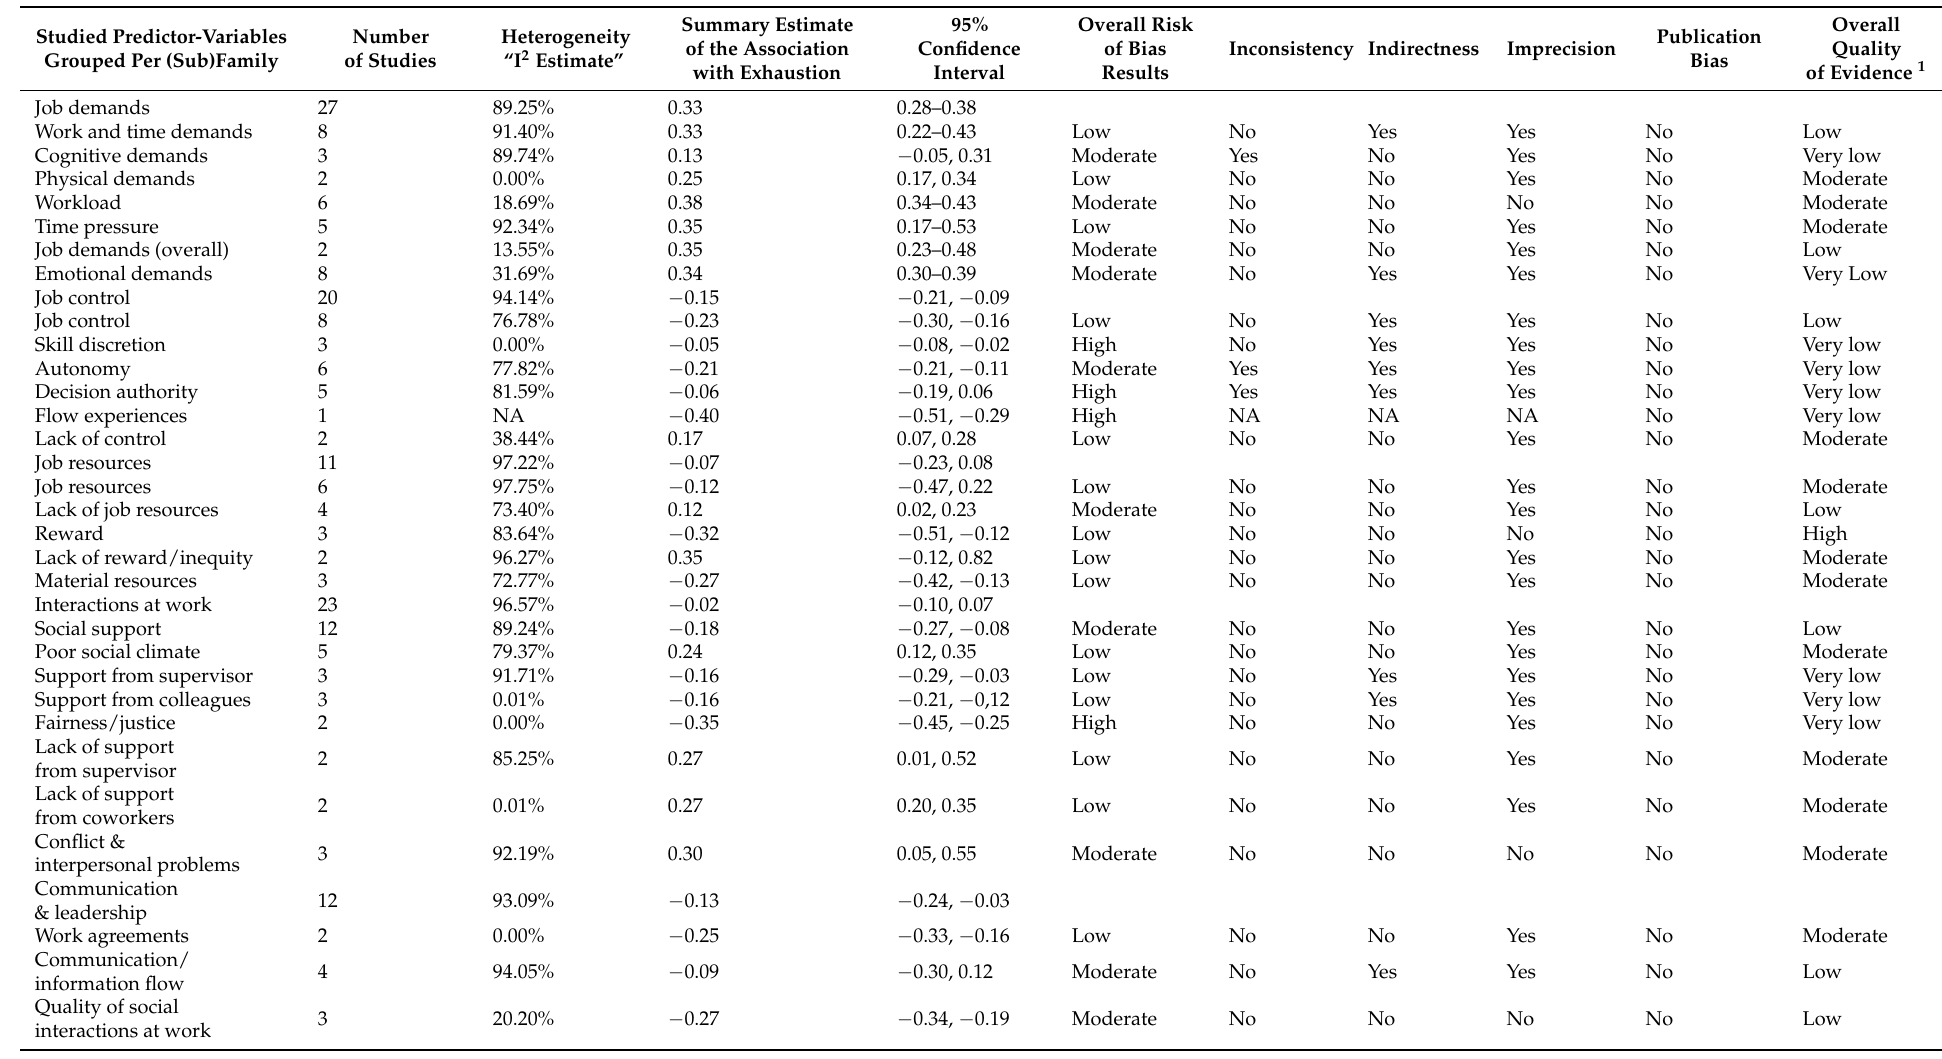
Table 1. Meta-analysis results per subgroups of studied